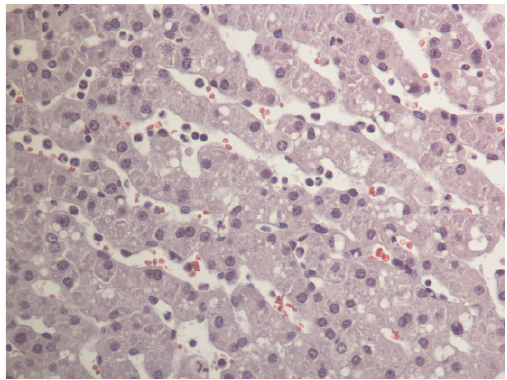
Figure 3 - The histological aspects of a transplanted liver at 3 hours after reperfusion. Note the presence of sinusoidal dilatation, steatosis and sinusoidal neutrophils.